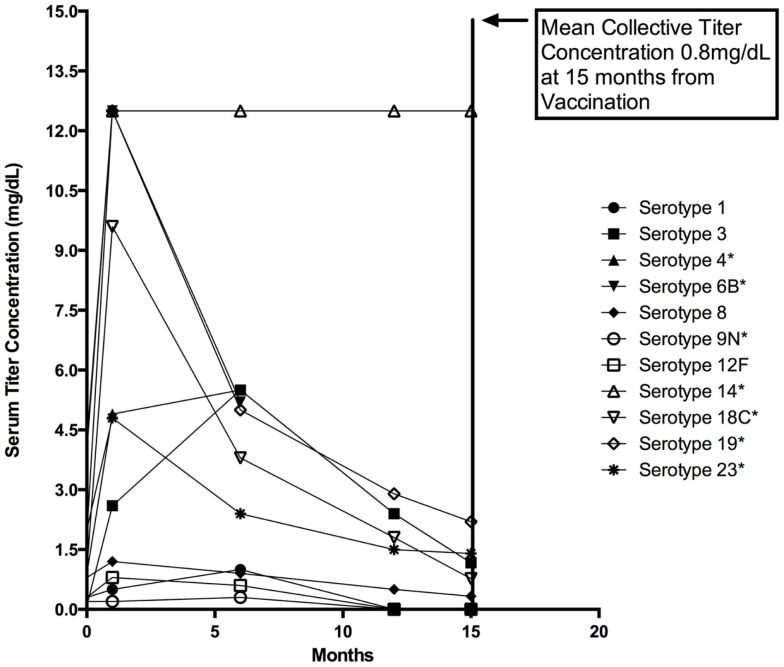
Twenty-three valent pneumococcal vaccine response. Various pneumococcal vaccine serotype titers plotted together before vaccination and at represented intervals following vaccination with Pneumovax © at 4, 24, 52, and 60 weeks. Vaccination was performed at 3 years of age following a complete series of the pneumococcal conjugate (Prevnar 7©) vaccine at recommended ages (AAP schedule) (13). Note the serotypes indicated with an asterisk (*) indicate those included in the Prevnar 7 vaccine. For reference, minimally protective titer levels are accepted to be ≥1.3 mg/dL [Bonilla et al. (14)]. Mean and one standard deviation are represented for each group. Mean serotype titers for each time point shown are: 1.4 μg/dL (Pre), 3.1 μg/dL (4 weeks), 2.4 μg/dL (24 weeks), 1.0 μg/dL (52 weeks), and 0.80 g/dL (60 weeks).